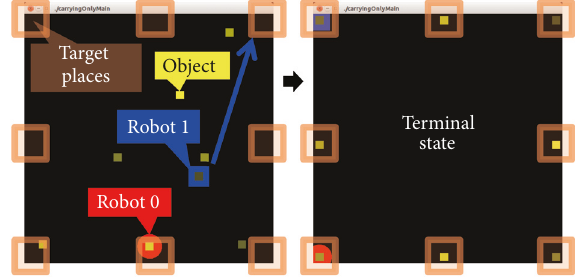
Figure 9: Simulation: heterogeneous robots and multiple carrying tasks.